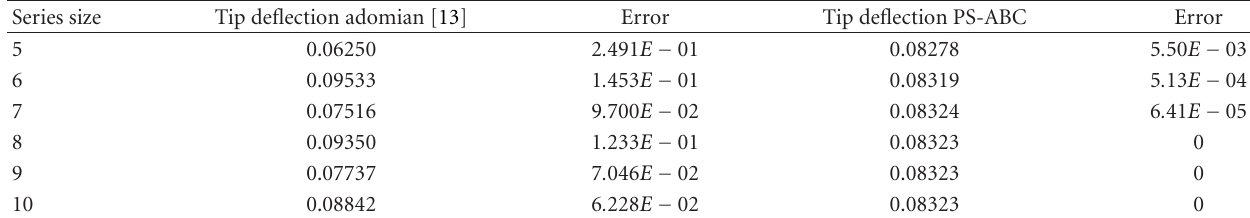
Table 2: A comparison between the evaluated tip deflection of a typical MWCNT cantilever using di ff erent terms of PS-ABC method and Adomian decomposition method for f = 0 .